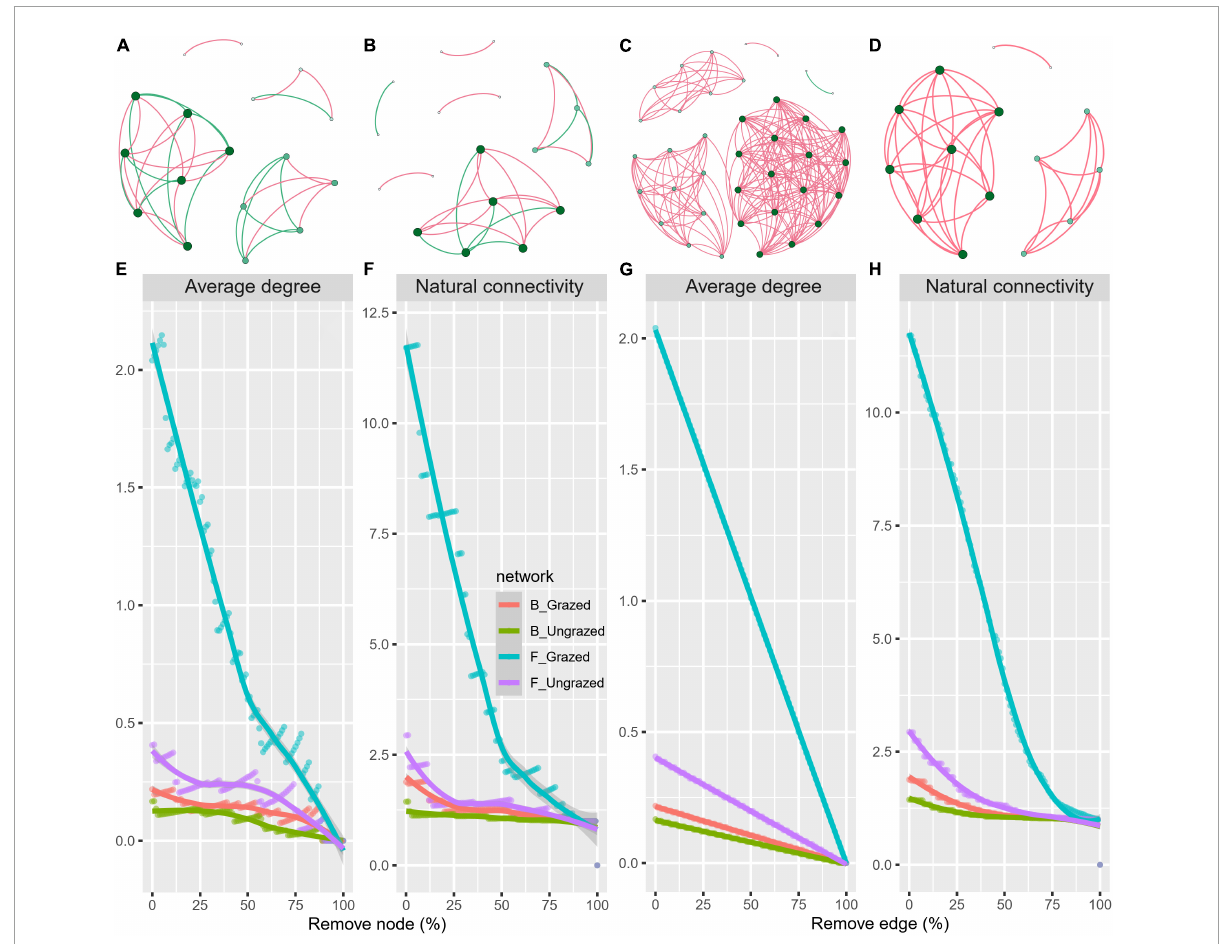
FIGURE4 Soil bacterial (A,B) and fungal (C,D) co-occurrence networks under grazed (A,C) and ungrazed (B,D) , and network robustness analysis (E–H) for microbial communities between the grazed and ungrazed. A node suggests an individual OUT, its color and size are proportional to its degree; a link represents the significant Pearson correlations with r > 0.8 and the Benjamini and Hochberg corrected p < 0.01. A red line suggests a positive relationship, but a blue line suggests a negative relationship. Network robustness analysis showing smaller decline at the same proportion indicates more stability within